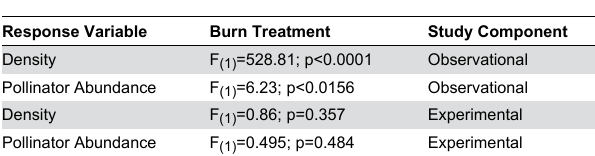
Table 1. Restricted estimated maximum likelihood results (REML) for the effect of fire on Verbesina alternifolia density and pollinator abundance by study component.